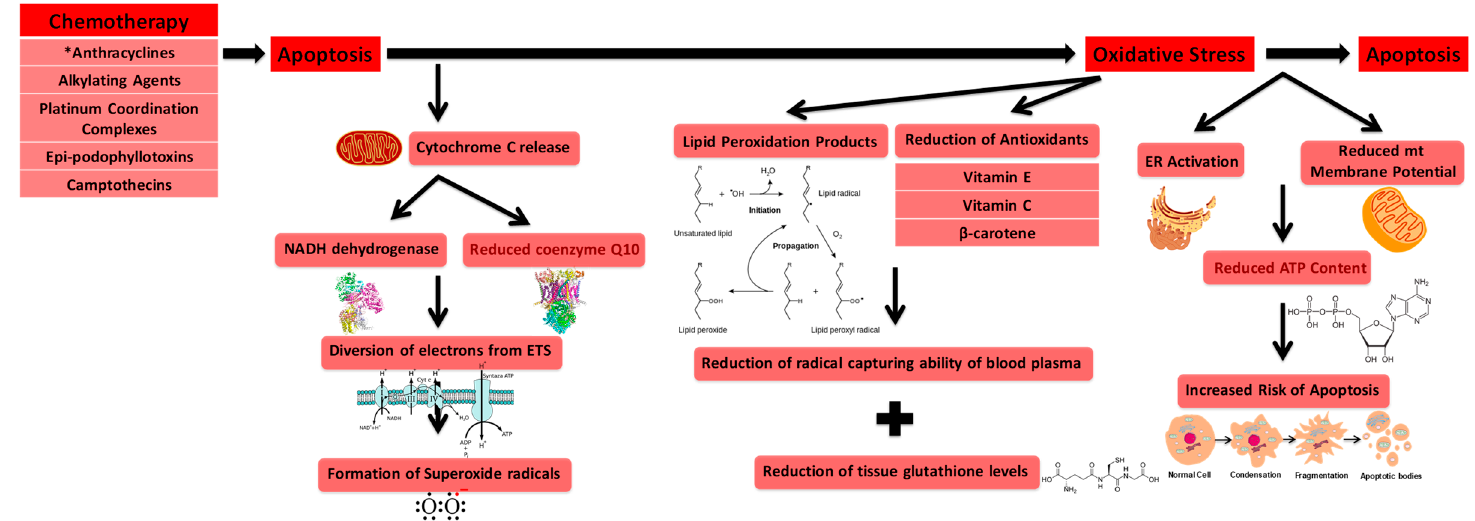
Figure 3. Proposed association between chemotherapeutic-induced apoptosis and oxidative stress elevation. Numerous types of chemotherapeutics such as anthracyclines, alkylating agents, platinum coordination complexes, epi-podophyllotoxins and camptothecins are known to contribute to increased apoptosis. This increased apoptosis has been shown to lead directly to an increase in oxidative stress. Release of cytochrome c encompasses a pathway that leads to apoptosis-induced oxidative stress. Cytochrome c release diverts electrons away from the electron transport system via NADH dehydrogenase and reduced coenzyme Q10, ultimately forming superoxide radicals. Additionally, lipid peroxidation products as well as the subsequent reduction of antioxidants (vitamin E, vitamin C, β -carotene) leads to oxidative stress elevation due to a reduction of the radical capturing ability of blood plasma as well as a diminution of tissue glutathione levels. Interestingly, although apoptosis leads to an increase in oxidative stress, elevated levels of oxidative stress are also shown to contribute to further apoptosis. Endoplasmic reticulum activation as well as a reduction of mitochondrial membrane potential due to elevated levels of superoxide is shown to reduce ATP content and ultimately contribute to an increased risk for apoptosis.